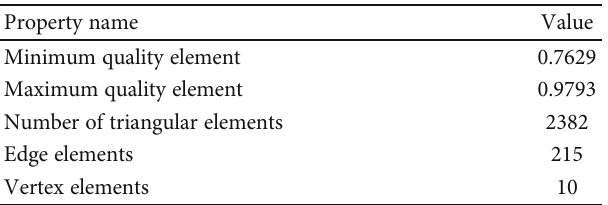
Figure 1: Geometrical construction of the channel. Table 1: Mesh